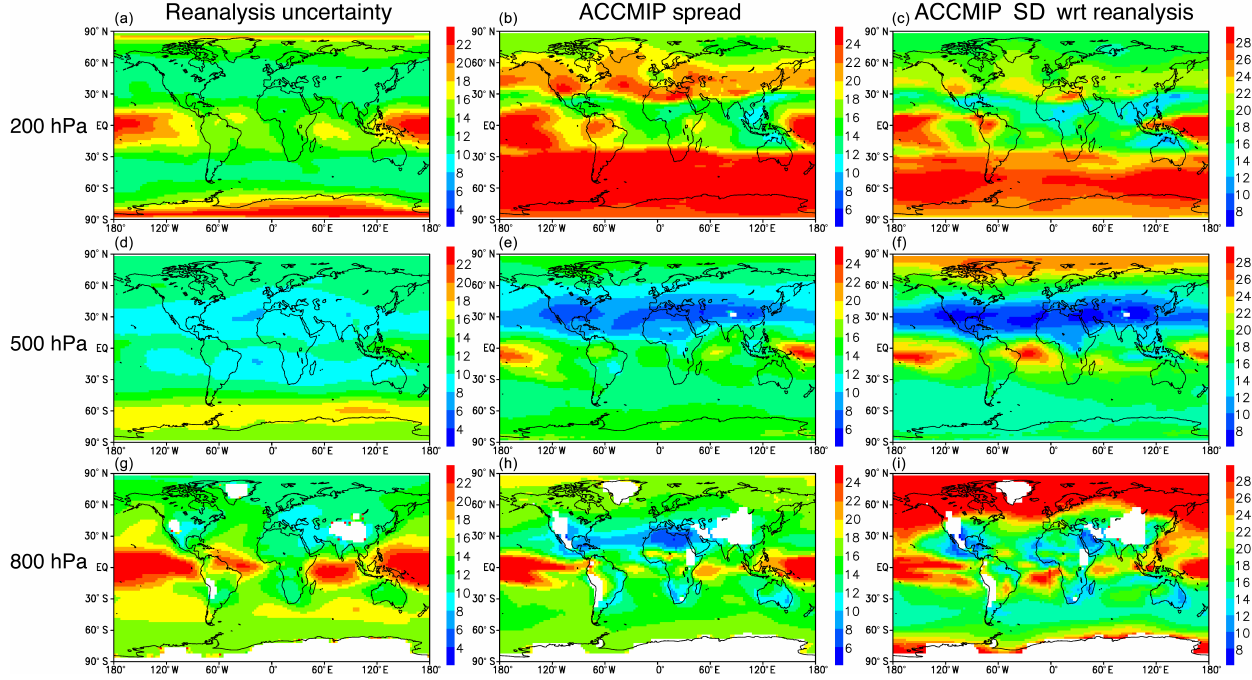
Figure 11. Global distributions of relative value (in %) of reanalysis uncertainty (a, d, g) , standard deviation among the ACCMIP models (b, e, h) , and ACCMIP model standard deviation with respect to the reanalysis for the annual mean concentration (c, f, i) . From top to bottom, results are shown for global distributions at 200, 500, and